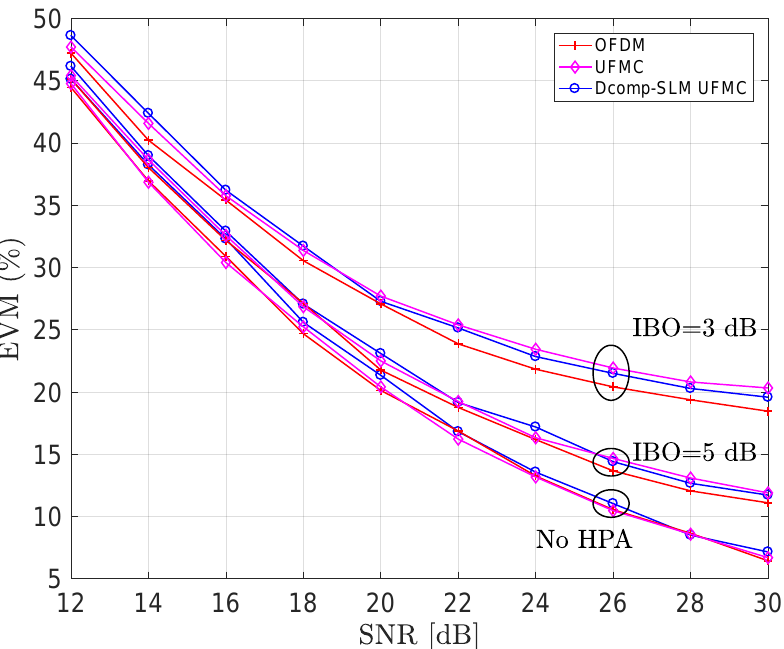
Figure 8. EVM performances of the proposed Dcomp-SLM comparing to the original OFDM and UFMC signals, in the presence of Rayleigh fading channel, for various IBO levels at N = 512 and U = 6